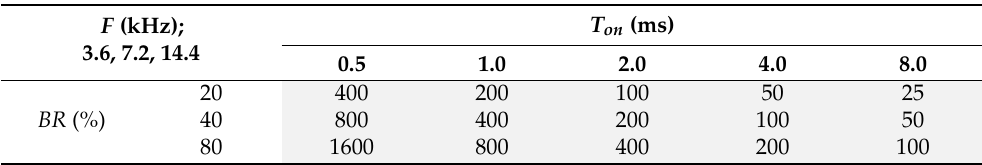
Table 3. Experimental conditions: Base frequency F (kHz), burst ratio BR , voltage input time of burst signal T on and Burst frequency f + (Hz); show in gray.